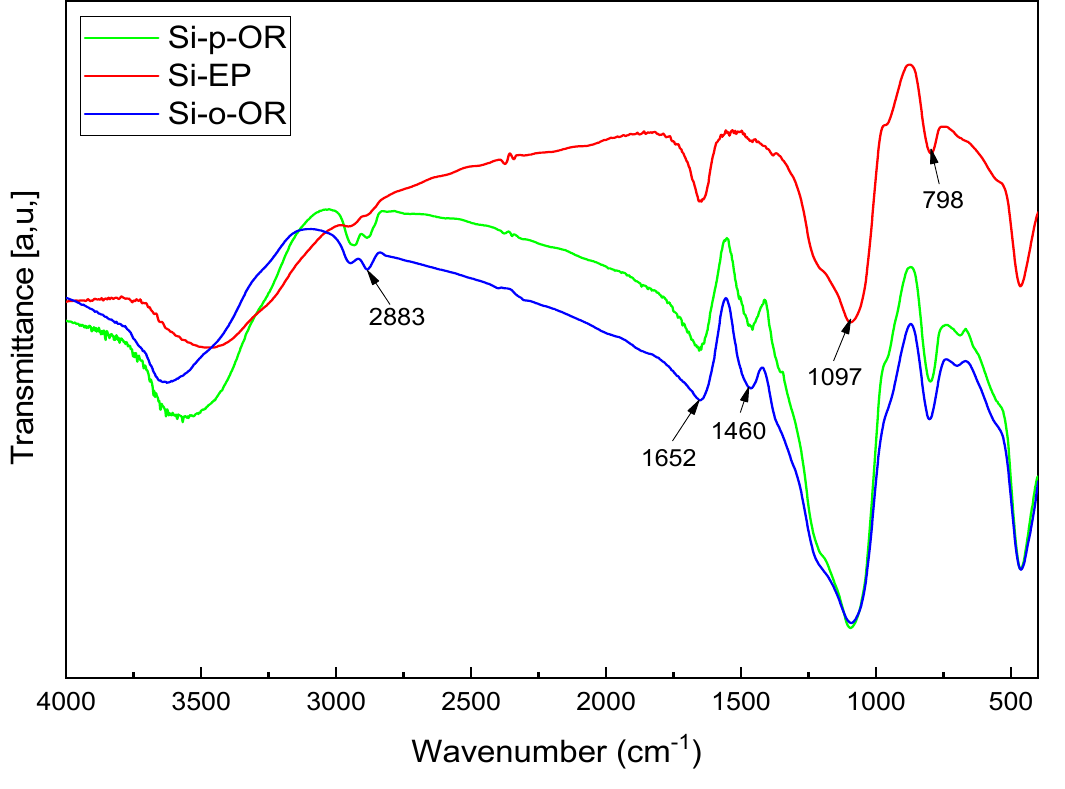
Figure 1. FTIR spectra of Si-EP, Si-o-OR and Si-p-OR. The surface morphologies of Si-o-OR and Si-p-OR were observed by scanning elec- tron micrographs (SEM). As displayed in Figure 2, both materials present similar rough surfaces, with a wide distribution of particle micrometer-measured size. In contrast, both materials were better dispersed than SiEP . The results confirm the successful introduction of Schiff base ligands over SiEP